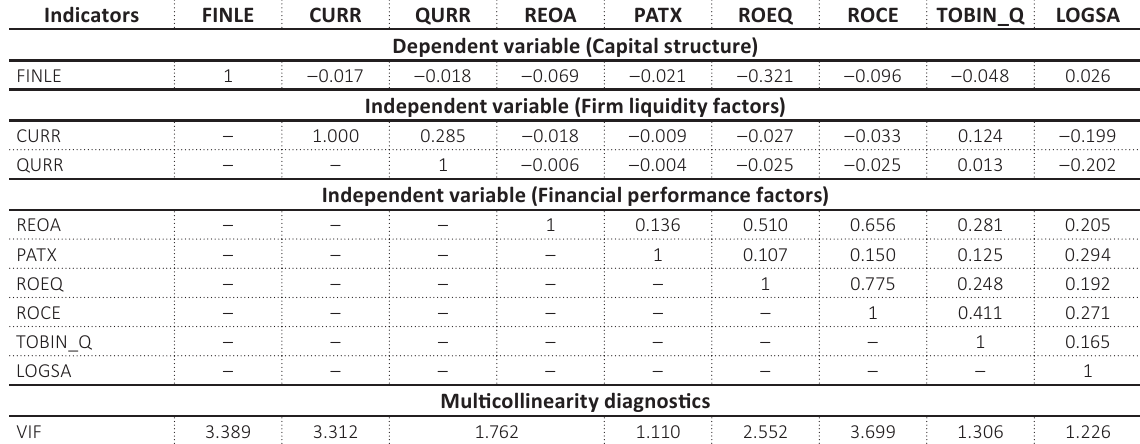
Table 4. Correlation